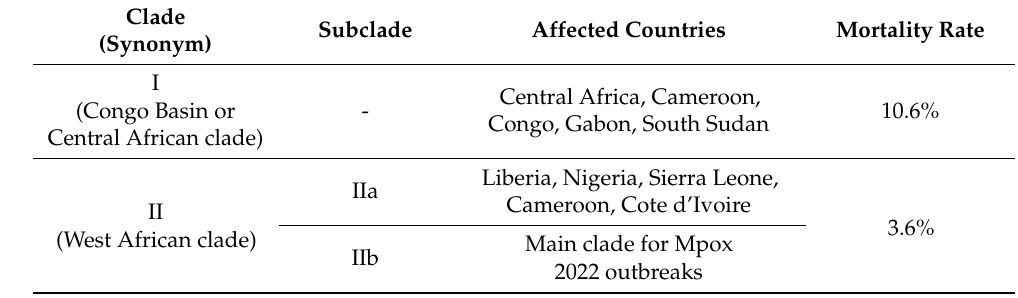
Table 1. Clades of MpoxV. Clade (Synonym)